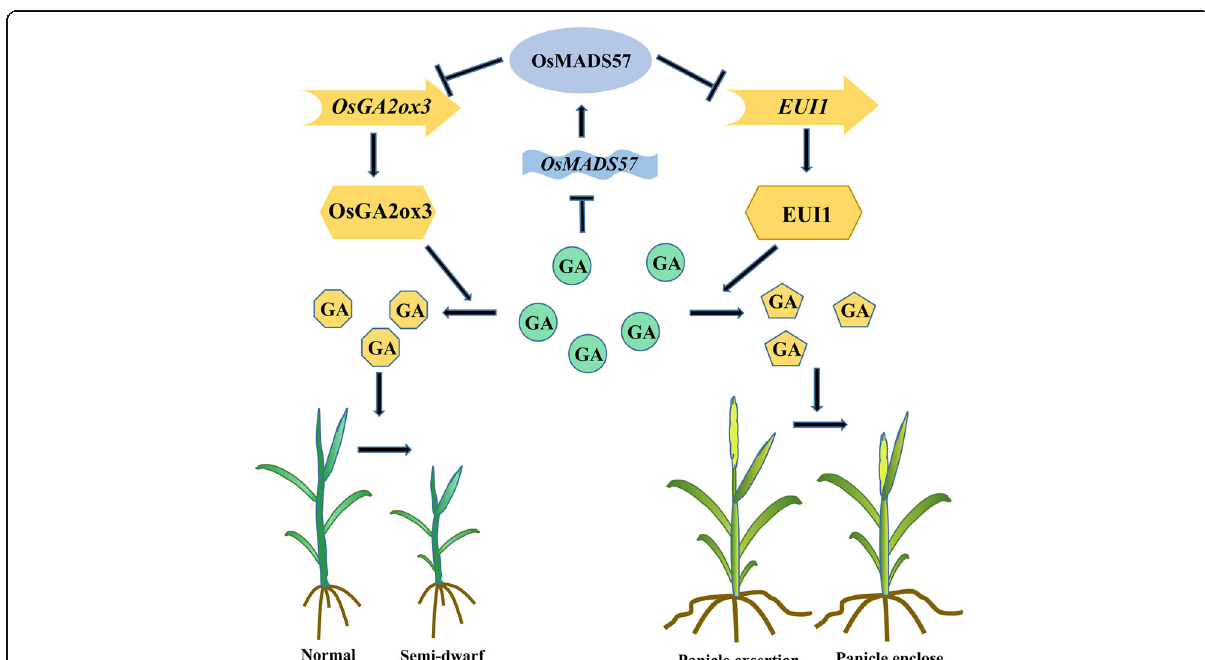
Fig. 7 Model of OsMADS57 regulatory network through GA catabolic genes. The expression of OsMADS57 is inhibited by GA 3 . And OsMADS57 suppresses the transcription of OsGA2ox3 and EUI1 that are involved in GA deactivation. Deficiency of OsMADS57 protein enhances the expression of OsGA2ox3 and EUI1 , which results in converting from bioactive GA to deactivated GA, thus reducing bioactive GA levels. Plants deficiency in bioactive GA shows panicle enclosure and semi-dwarf